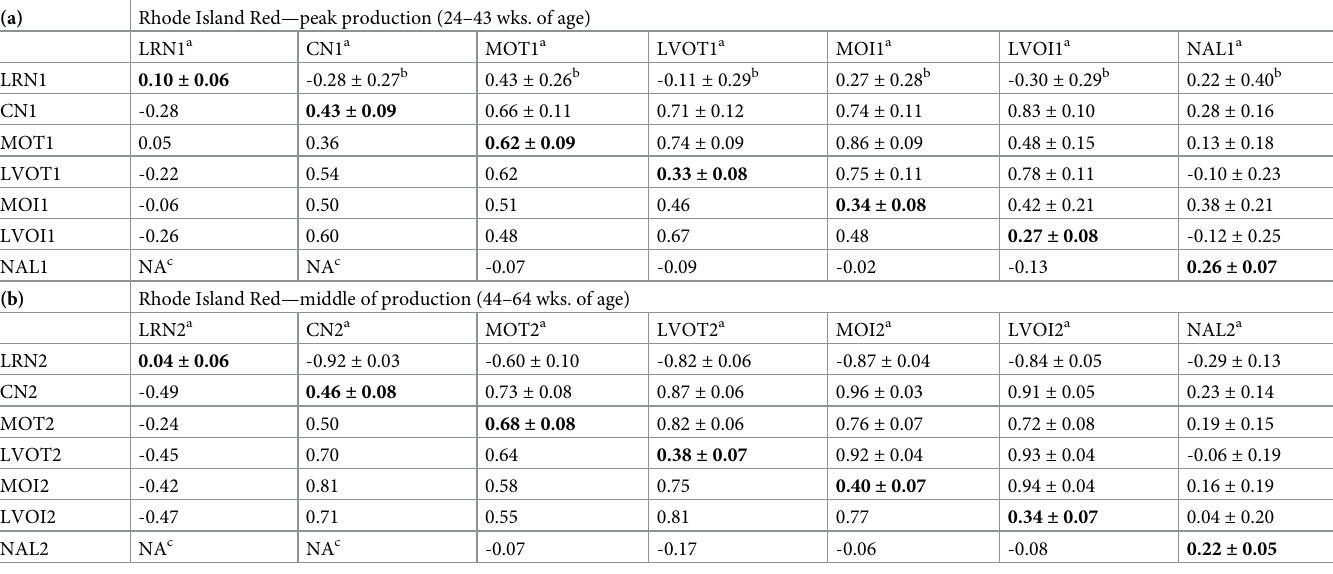
Table 4. Heritability estimates (Mean ± SEM; on diagonal), genetic correlations (Mean ± SEM; above diagonal) and phenotypic correlations (below diagonal) for the nest-related traits at the peak (a) and middle (b) production period in the Rhode Island Red line. (a) Rhode Island Red—peak production (24–43 wks. of age) LRN1 a